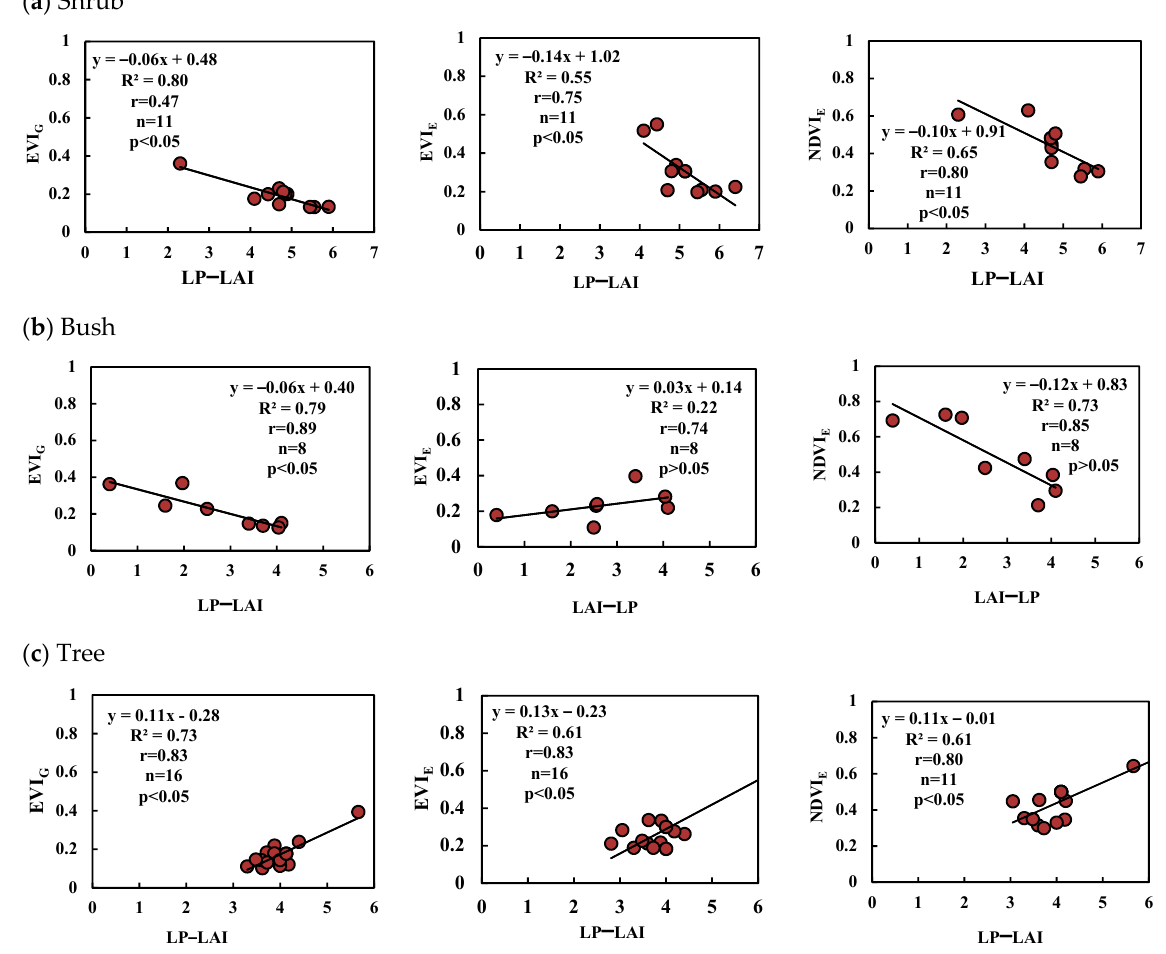
Figure 8. Scatter plots of remote sensing vegetation indices and LP-LAIs for different PFTs of ( a ) shrub, ( b ) bush, and ( c ) tree.